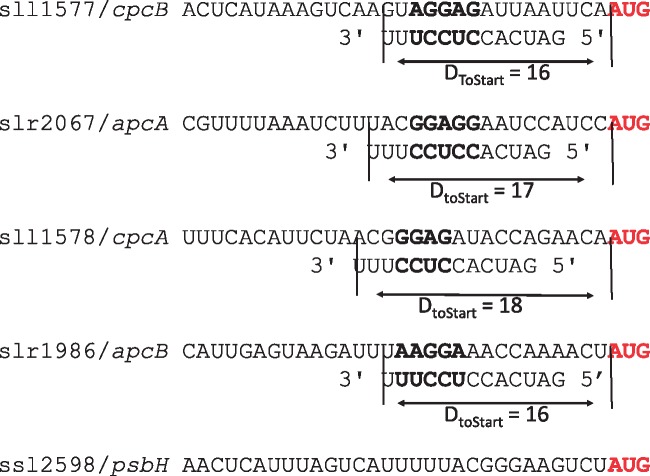
—SD/anti-SD interactions can be found between mRNA and 3′ tail of 16S rRNA in four of the five S. sp. genes with the most abundant proteins, but not in ssl2598/psbH. In red is the start codon, in bold the SD/anti-SD pair.